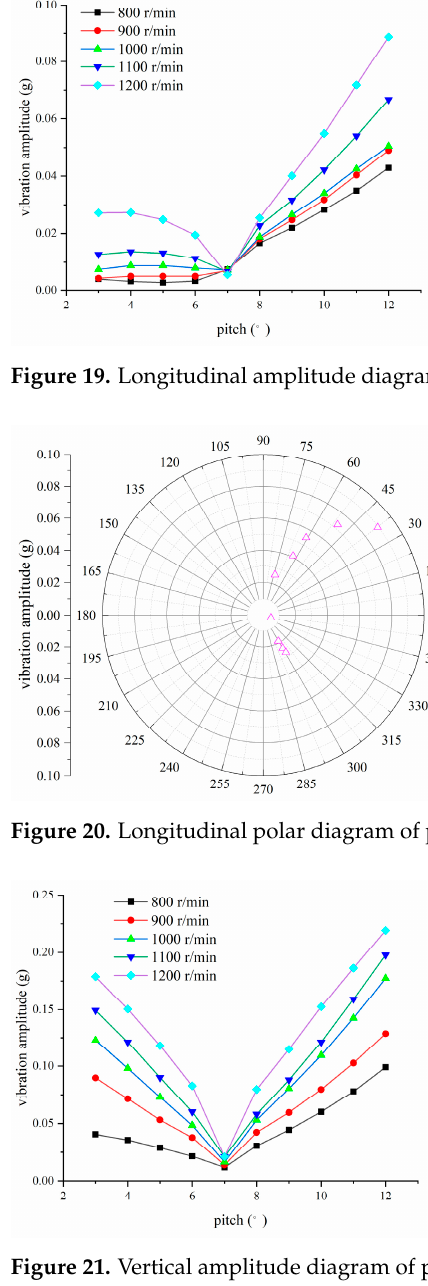
Figure 22. Vertical polar diagram of pitch. It can be seen from Figures 17–22 that the vibration amplitude increases with the pitch. The unbalanced pitch has a great influence on the vertical vibration by the rotor speed. The unbalanced pitch has little influence on the lateral and longitudinal vibration by the rotor speed. The change in pitch has an obvious effect on the phase change. With the change in pitch, the phase first increases and then decreases. 3.4. Influence of Trailing-Edge Flap on 1 Ω Vibration